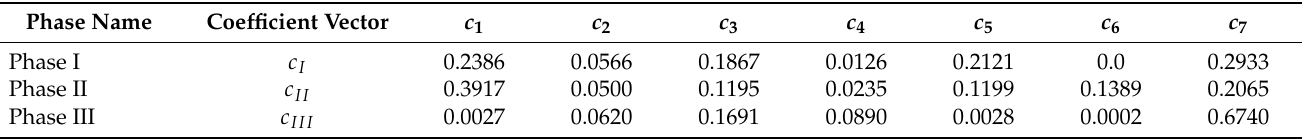
Table 10. Trapezoidal modified law identified coefficients (adimensional values) for each phase of the considered actual